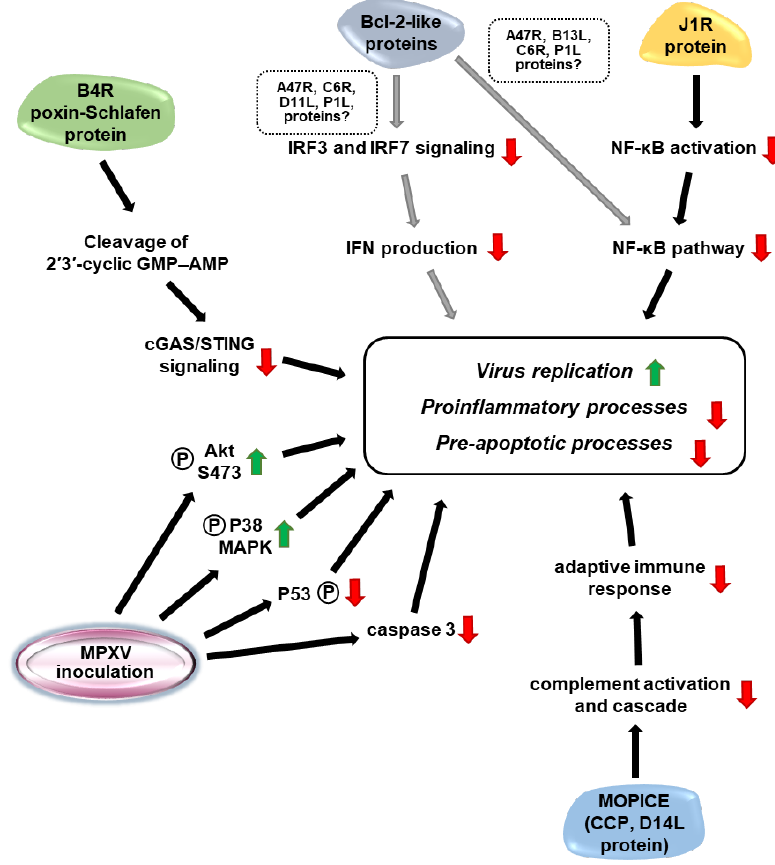
Figure 3. Schematic representation of cellular processes modulated by monkeypox virus proteins (green arrows, upregulation; red arrows, downregulation). Black arrows refer to experimentally verified result. Grey arrows show putative signaling concluded through mechanisms described for homologues of other orthopoxviruses.